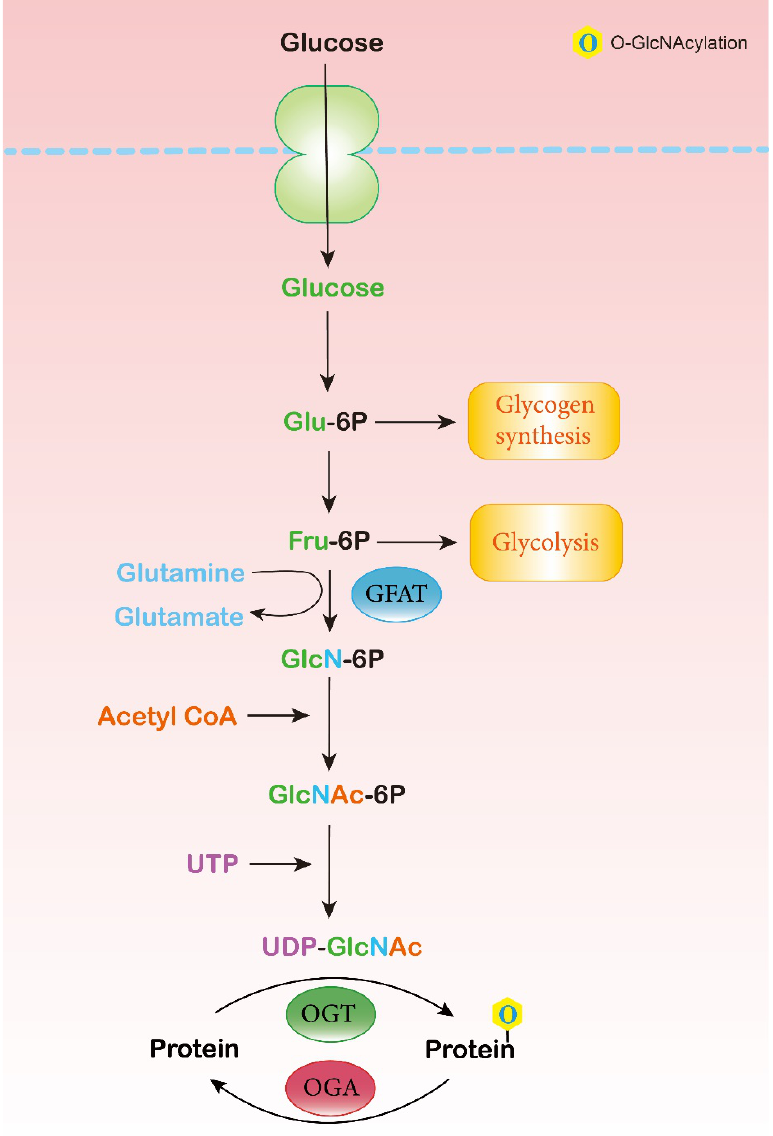
Figure 1. The hexosamine biosynthesis pathway (HBP) and O-GlcNAcylation. The HBP integrates glucose, glutamine, acetyl-CoA, aspartic acid, and UTP to synthesize the final product, UDP-GlcNAc, the glycosyl donor for O-GlcNAcylation. GFAT, glucosamine fructose-6-phosphate amidotransferase; GlcNAc, N-acetylglucosamine; UTP, uridine triphosphate; OGT, O-GlcNAc transferase; OGA, β -N-acetylglucosaminidase; O, O-GlcNAcylation.